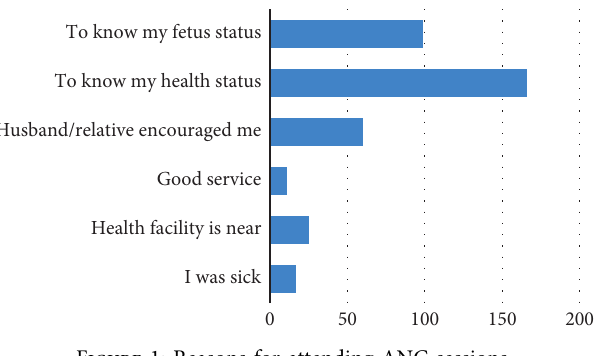
Figure 1: Reasons for attending ANC sessions.